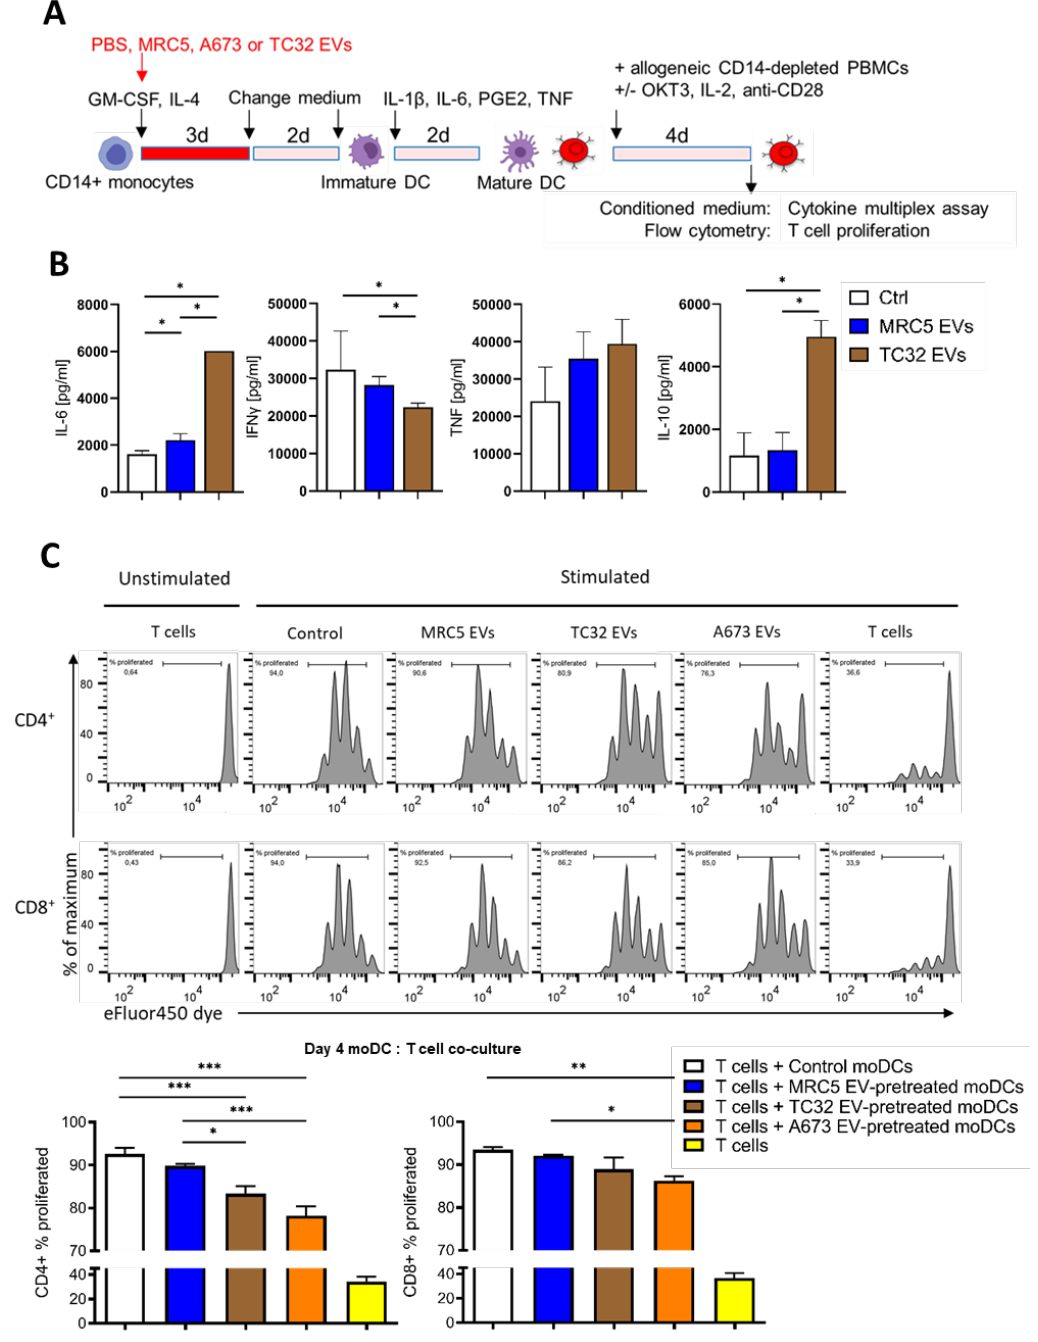
Figure 5. CD14 + monocytes differentiated in the presence of EwS EVs suppress T cell activation. Experimental design ( A ), cytokine profiling ( B) , and flow cytometry analysis ( C ). ( B ) CD14 + monocytes from two donors were differentiated in the presence of 3 × 10 9 EVs/mL from indicated cell lines and co-cultured with allogeneic CD14-depleted PBMCs for 4 days. Conditioned medium was assessed by cytokine multiplex assay. ( C ) Allogeneic CD14-depleted PBMCs were labeled with eFluor450 dye, stimulated with coated OKT3, IL2, and anti-CD28 antibodies, and co-cultured for 4 days with CD14 + monocytes differentiated in the presence of the indicated EVs. Representative flow cytometry results (top) and their quantification (bottom) of CD4 + and CD8 + T cell proliferation (representative of three independent donors). Results were obtained with two ( B ) or three ( C ) independent EV preparations. Data are presented as mean ± SD. Mann-Whitney U test (B) and one-way ANOVA with multiple comparison Turkey test ( C ) were used to calculate p values. * p ≤ 0.05, ** p ≤ 0.01, *** p ≤